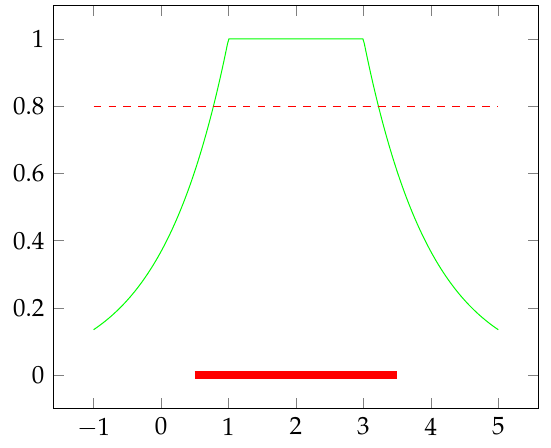
Figure 2. A figure demonstrates the ball obtained as the strict 0.8-cut of the fuzzy set B 2,1 ( y ) , where d ( x , y ) = | x − y | . X = IR, E is the fuzzy equivalence relation with respect to the product